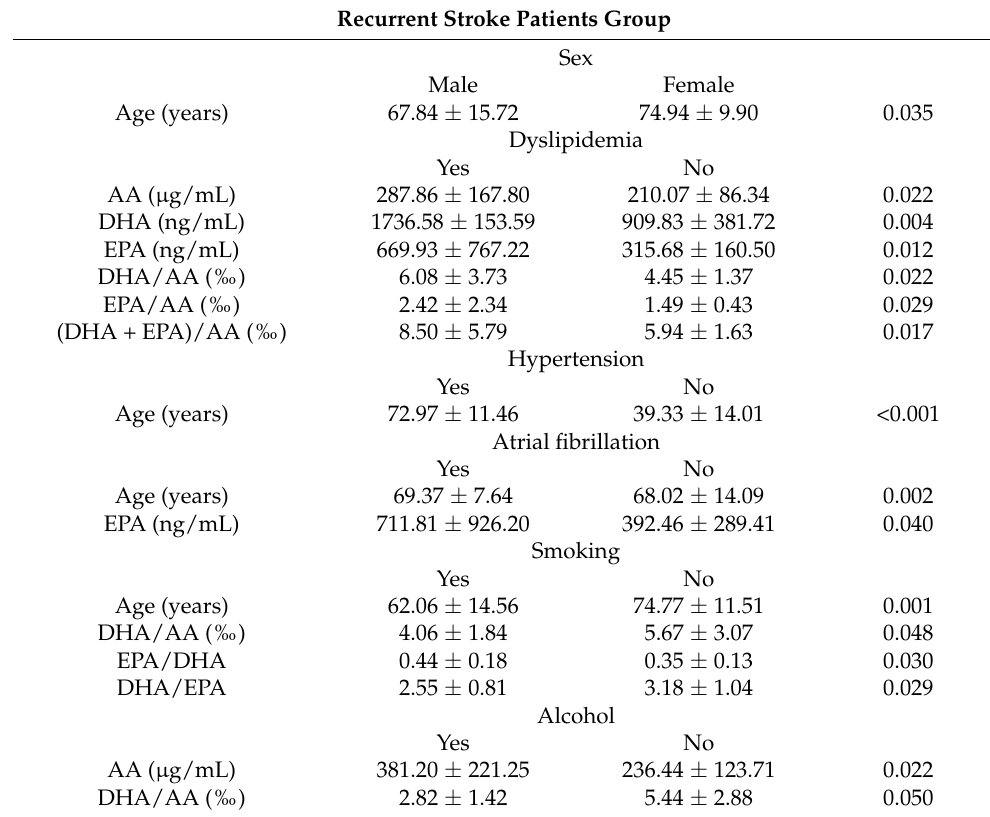
Table 8. Stroke-history groups ANOVA